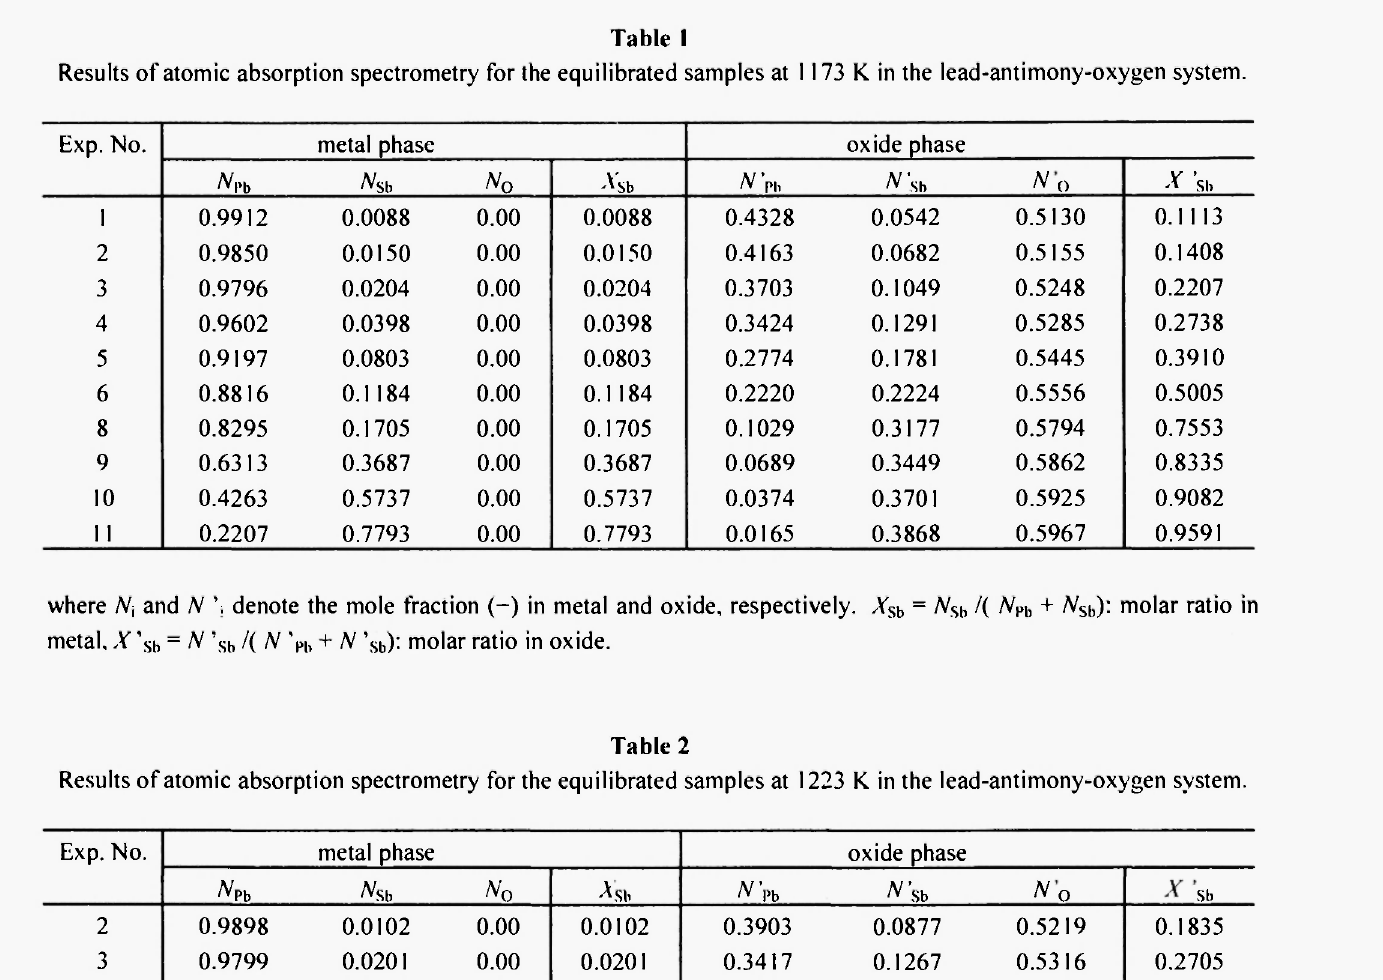
Results of atomic absorption spectrometry for the equilibrated samples at 1173 Κ in the lead-antimony-oxygen system. Exp. No.